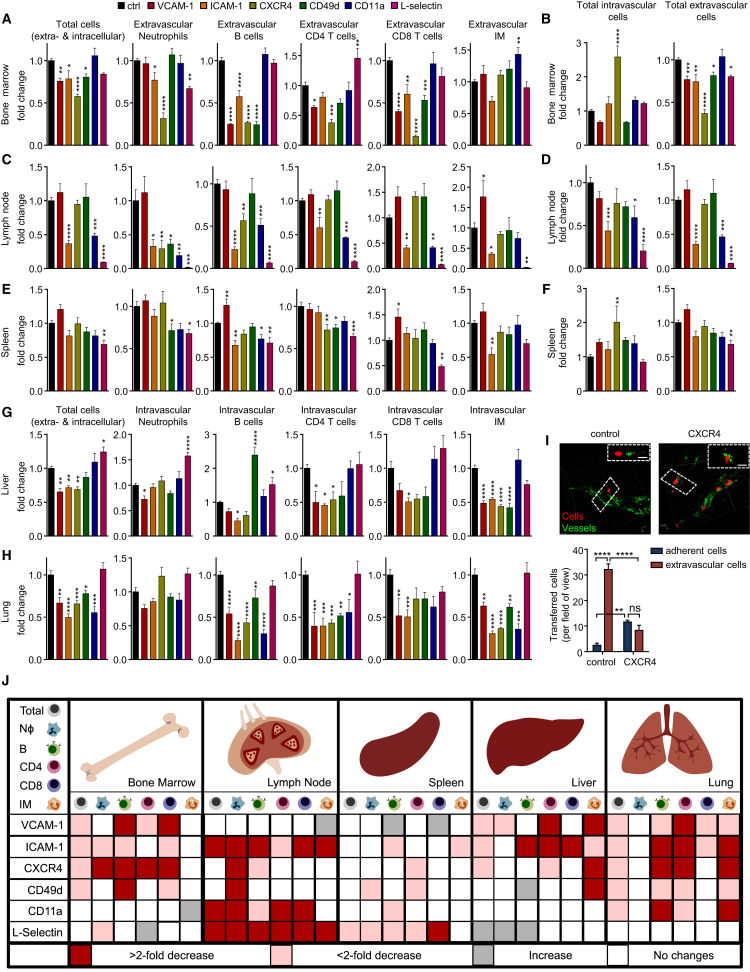
Chronopharmacological Targeting of Leukocyte Homing to Tissues(A–H) Adoptive transfer of donor cells to the bone marrow (A and B), lymph node (C and D), spleen (E and F), liver (G), and lung (H) of recipients treated with functional blocking antibodies or antagonists directed against the indicated molecules at ZT13. Cell numbers are normalized to control numbers (n = 4–8 mice; one-way ANOVA followed by Dunnett comparison to the control group). Localization of transferred cells in the bone marrow (B), lymph node (D), and spleen (F) is normalized to control localization (n = 4–8 mice; one-way ANOVA followed by Dunnett comparison to the control group).(I) Images and quantification of localization of donor cells in bone marrow after CXCR4 blockade. Boxes indicate exemplary cells whose localization within tissues is additionally shown in the z direction (n = 3 mice; unpaired Student’s t test). Scale bars: 10 μm.(J) Overview of functional blocking effects on leukocyte recruitment to organs, targeting the indicated molecules (n = 4–8 mice; one-way ANOVA followed by Dunnett comparison to the control group).∗p < 0.05, ∗∗p < 0.01, ∗∗∗p < 0.001, ∗∗∗∗p < 0.0001. All data are represented as mean ± SEM. See also Figure S5.